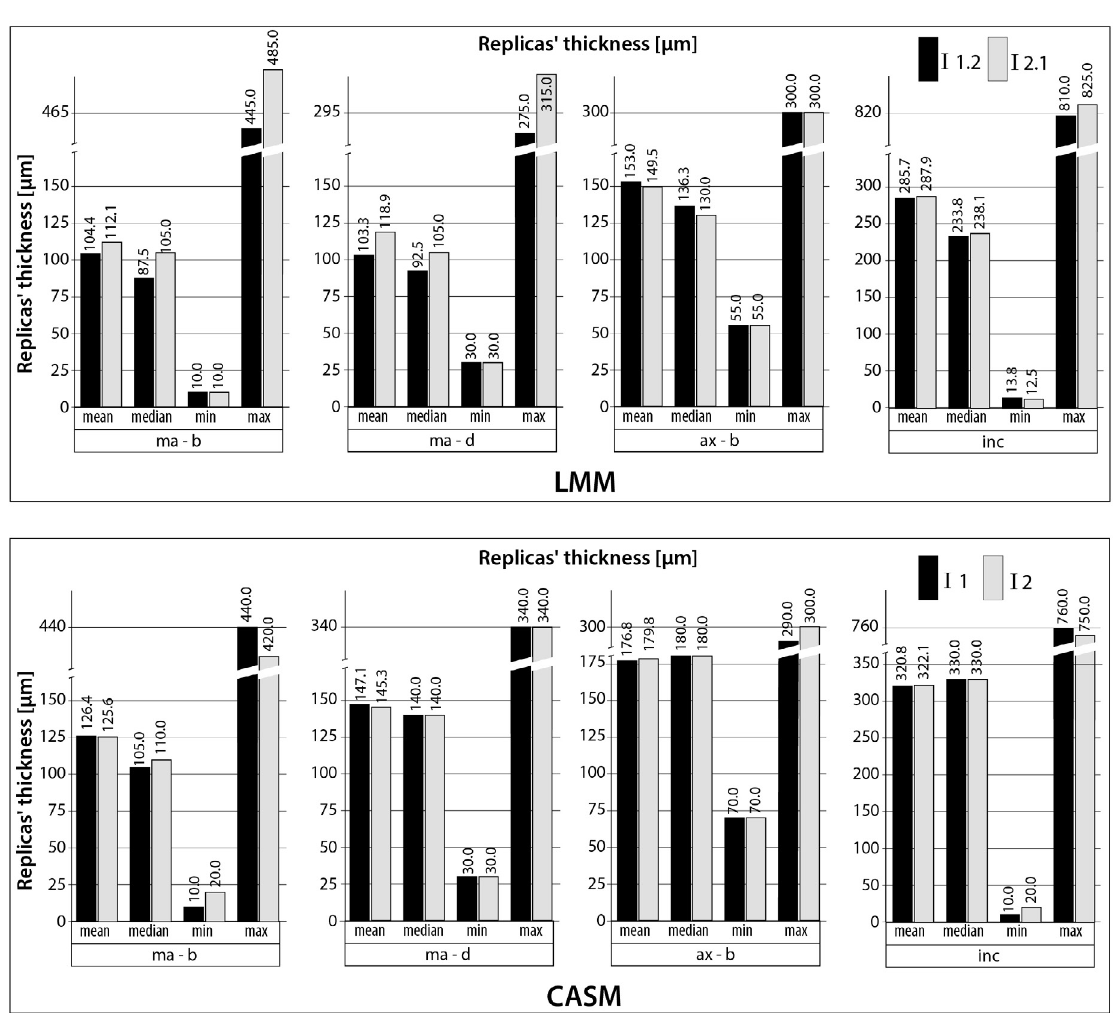
Figure 4- Replicas’ thickness (n=80 for each measurement technique) for the light microscopy measurements (LMMs) and for the computer-assisted measurements (CASMs); I1.2= second measurements of the first investigator (LMM); I2.1= measurement of the second investigator (LMM); I1 and I2= measurements of the first and second investigators (CASM); Measurement points: marginal-buccal (ma-b), marginal-distal (ma-d), axial-buccal (ax-b), incisal Table 1- Intraclass correlation coefficient analyses for intra-rater reliability for LMM and for inter-rater reliability for LMM versus CASM; Bland-Altman bias analysis for intra-rater agreement for LMM and for inter-rater agreement for LMM versus CASM